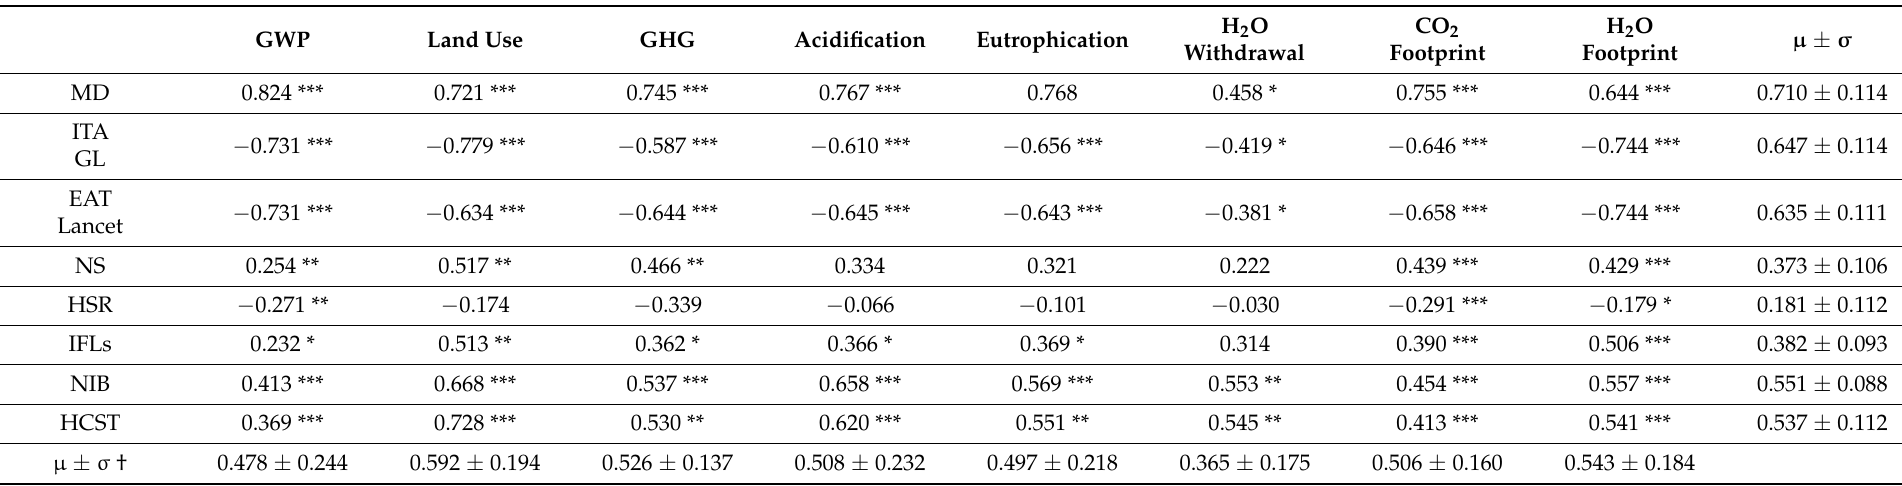
Table 2. Correlation matrix between food scales and environmental sustainability